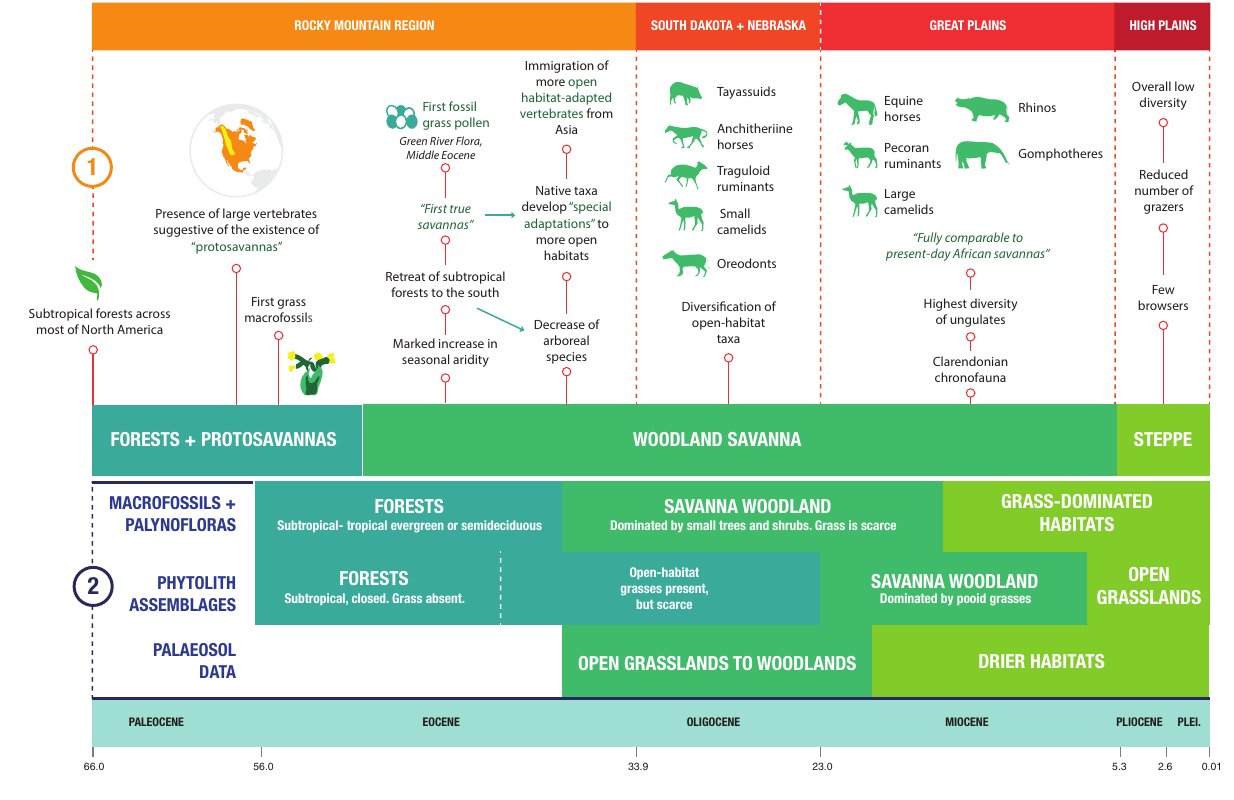
FIGURE 1 | Comparative timeline of the changing ecosystems of North America during the Neogene. (1) The perspective of Webb (1977), a traditional viewpoint dominated by evidence recovered mainly from mammalian assemblages. (2) The perspective of Strömberg (2011), a viewpoint dominated by paleobotanical